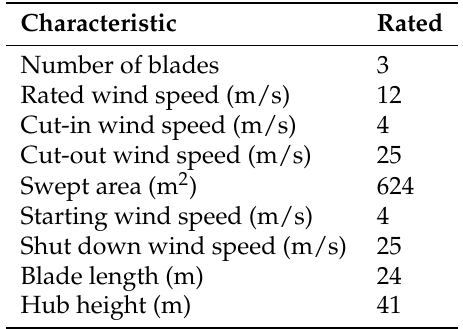
Table 1. Overview of the characteristic for the 200 kW